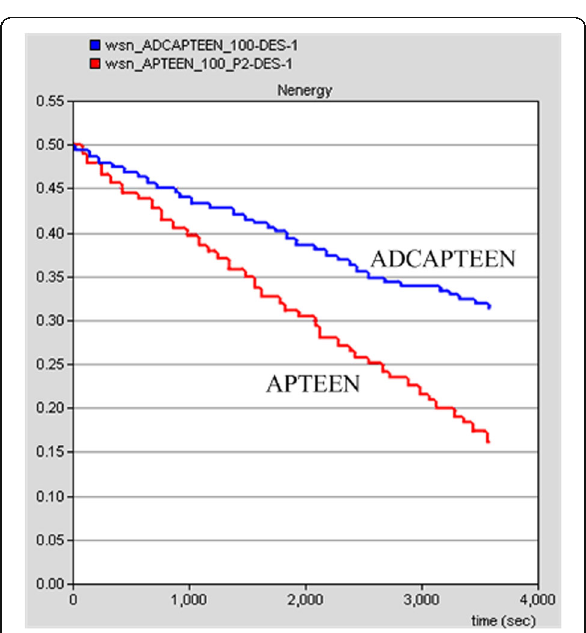
data to the VCH of the cluster, and the VCH for- wards the data to the sink node at a far distance. and VCH performs most of energy consumption.